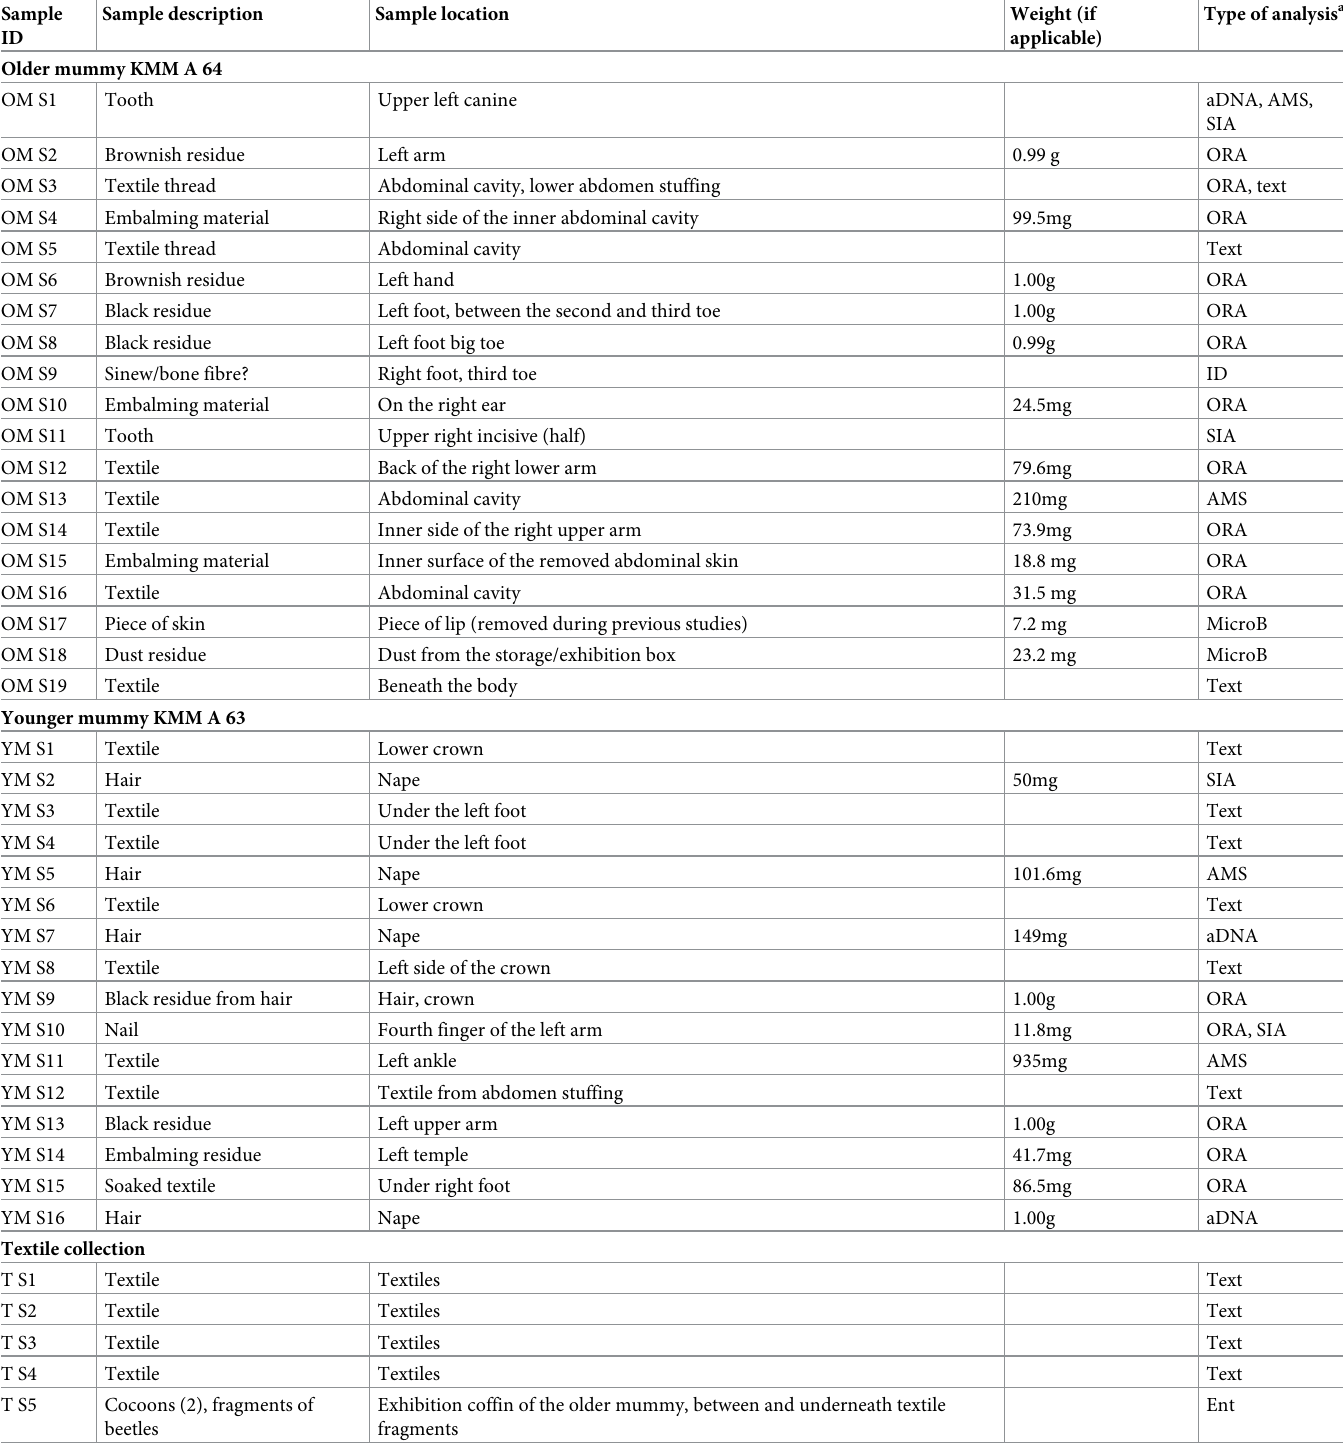
Table 1. List of samples collected from the two